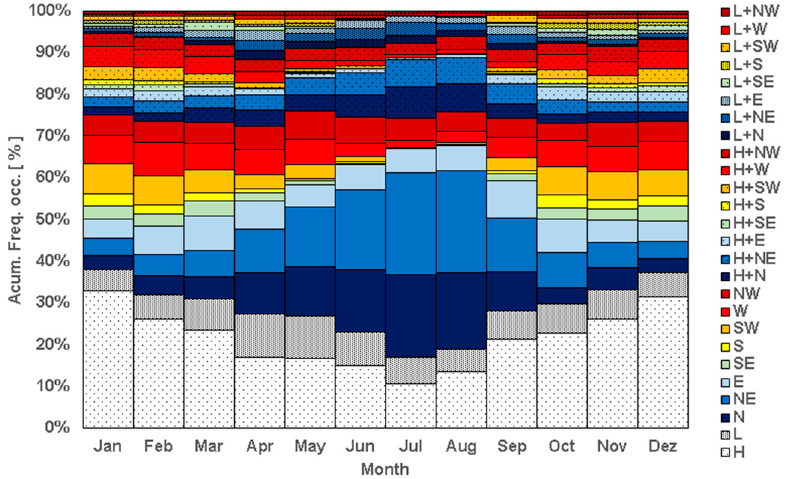
Figure 6. Monthly accumulated frequency of weather circulation types for the period between 1980 and 2018.